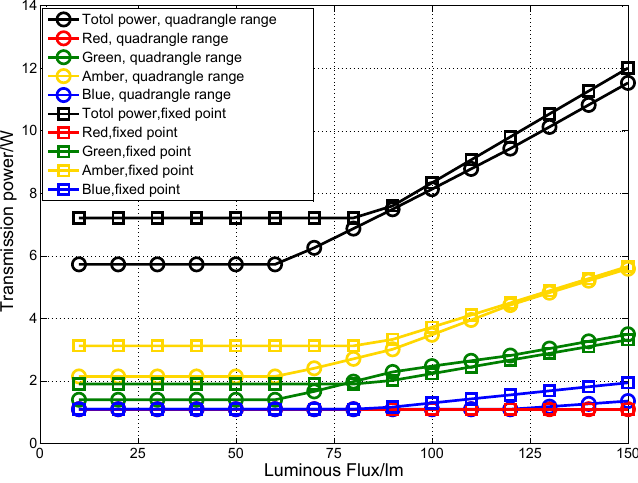
Figure 6. Transmission power of the proposed scheme with quadrangle range chromaticity tolerance and a fixed chromaticity point at crosstalk coefficients (cid:101) = 0.1 and CCT = 3000 K.